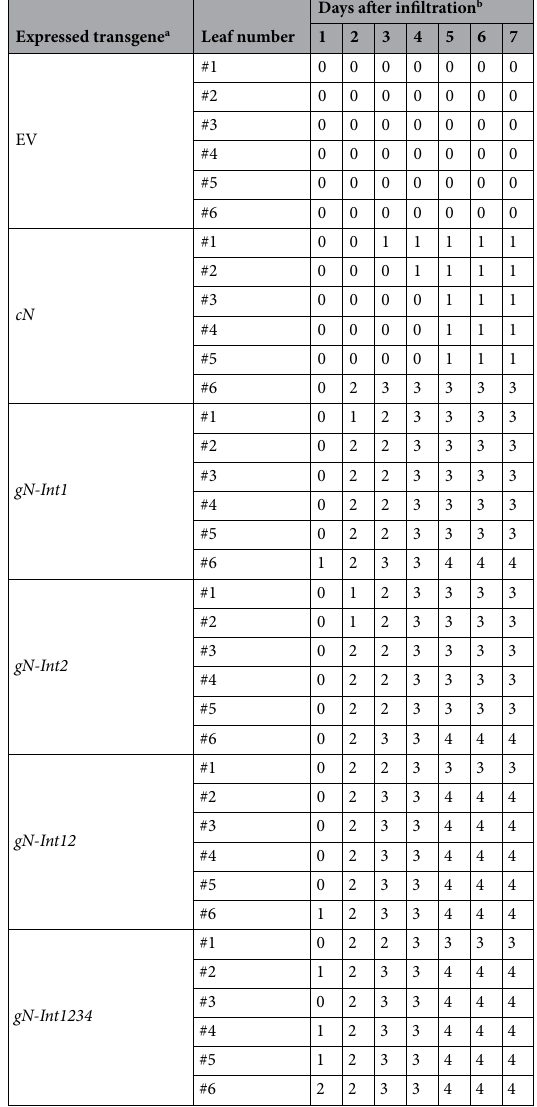
Table 1. Effects of introns 1 and 2 during N -mediated progression to cell death within tobacco leaves expressing p50 elicitor. a Each of five N transgenes ( cN , gN - Int1 , gN - Int2 , gN - Int12 , and gN - Int1234 ) was expressed together with p50 in the same tobacco leaf (#1 to #6). Agrobacterium with empty vector (EV) was used as a negative control. b Scoring criteria for cell death progress: 0, no visible signs of cell death; 1, change from a smooth to irregular surface of the abaxial epidermis; 2, signs of withering and clearing of leaf tissue; 3, formation of gray-to-brownish necrotic lesion; 4, formation of entirely chalky white